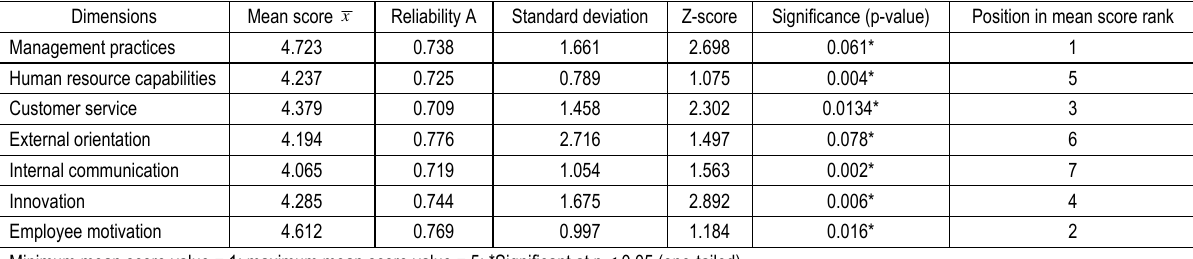
Table 1. Mean scores, reliability and mean score ranking of